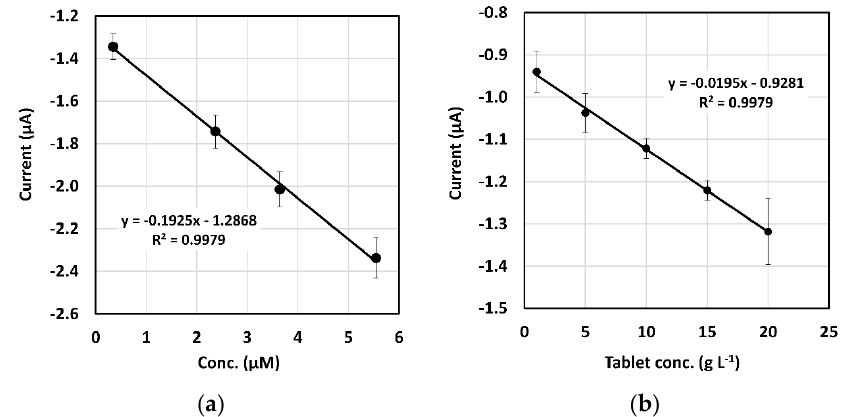
Figure 4. Calibration plots obtained with DRP-110CUPH for ( a ) electrogenerated chlorine and ( b ) chlorine generated with the chlorination tablet.